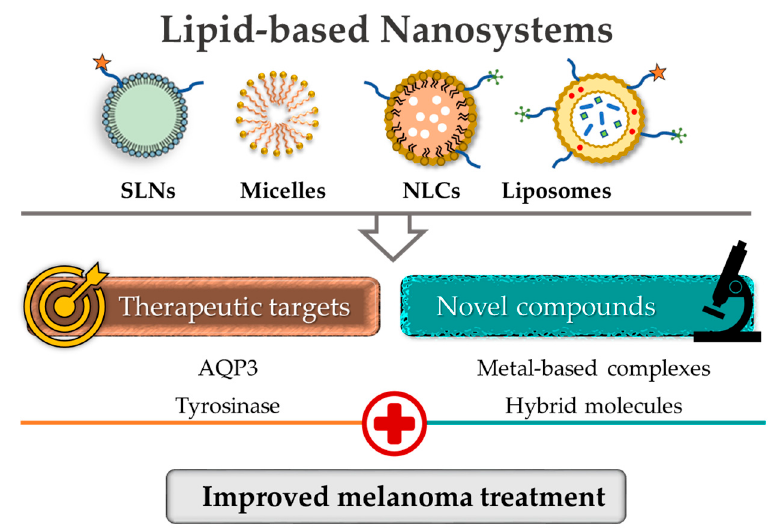
Figure 7. Lipid-based nanosystems as a strategy for melanoma management [158].